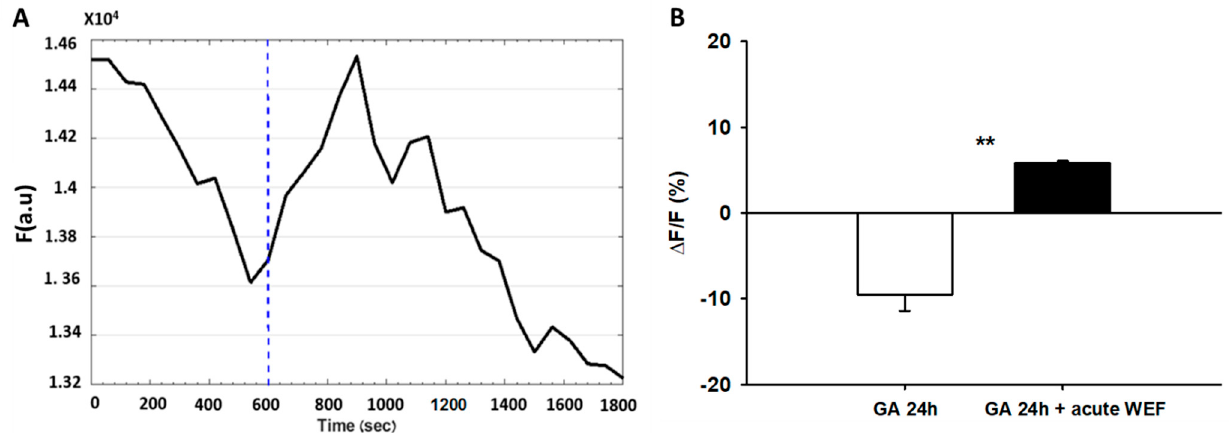
Figure 4. Effect of gambogic acid (GA) on membrane potential of myotubes induced by KCl. Cells were exposed to 200 nM GA and loaded with di-8-ANEPPS as described in legend to Figure 4. ( A ). Representative trace of a cell treated with GA for 24 h and exposed to KCl at the time indicated (dashed line). ( B ). Representative trace of a cell exposed to WEF for 24 h and subsequently to GA and WEF for 60 min before administration of KCl at the time indicated (dashed line). ( C ). Representative trace of a cell exposed to WEF and GA for 24 h before administration of KCl at the time indicated (dashed line). Note the blunted and transient response. ( D ). Mean ± SE values for cells in trace A ( n = 24), trace B ( n = 27), and C ( n = 6, initial indicates increase; end indicates decrease from peak). ** p < 0.01; *** p < 0.001 vs. 0.